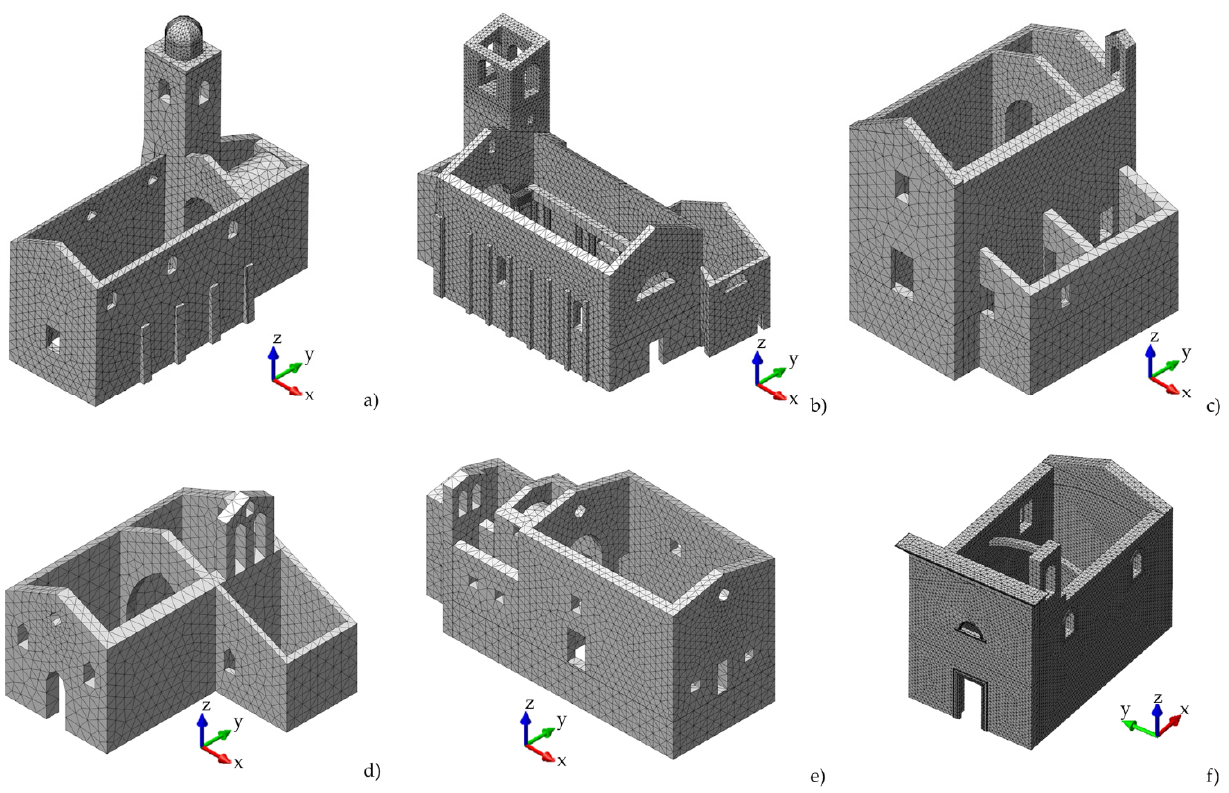
Figure 3. Numerical models of San Francesco Church in Montefortino ( a ), San Francesco Church in Sarnano ( b ), Sant’Anna Church in Camerino ( c ), Sant’Antonio Church in Ussita ( d ), Madonna of Valcora Sanctuary in Fiuminata ( e ), Santissimo Crocifisso in Arquata del Tronto ( f ). Table 1. Main characteristics of the numerical models of the six churches analyzed.